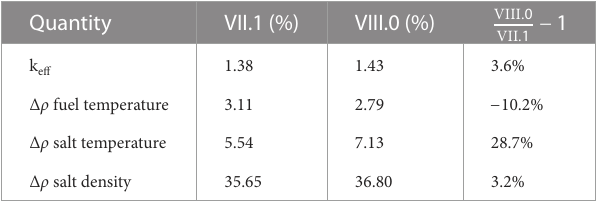
TABLE4 UCBPB-FHRuncertainties † inquantitiesofinterestduetonuclear datauncertainty,fordifferentENDF/Blibraryversions.